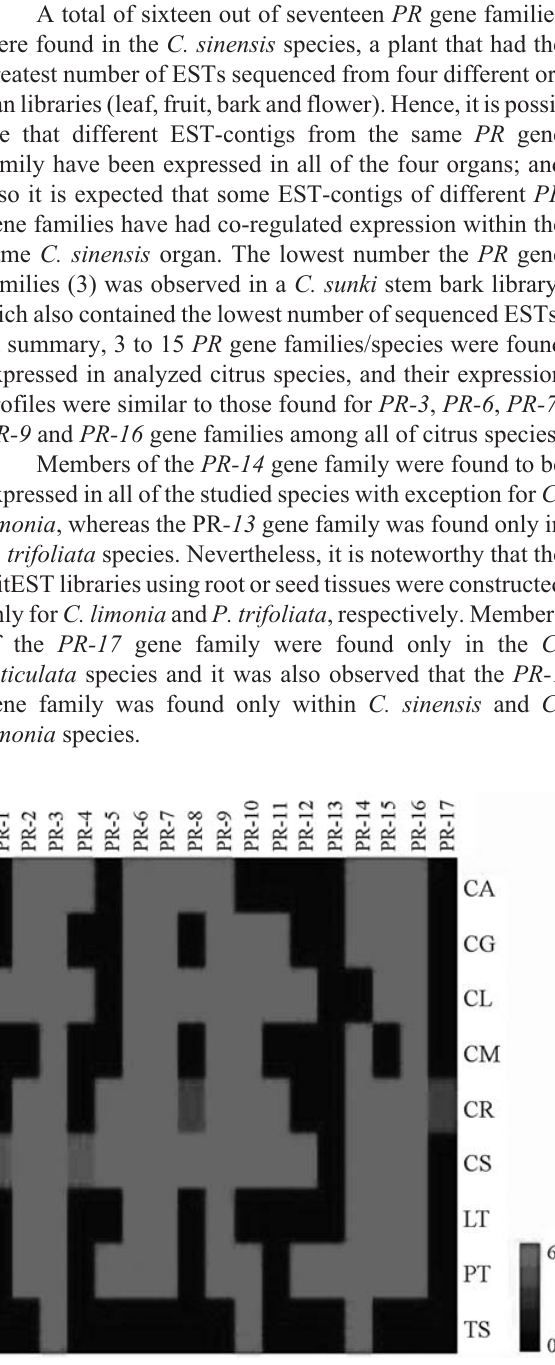
Figure 5 - PR -like gene families expression patterns present in each citrus species. Each citrus species is represented by a single row; each PR gene family ( PR-1 to PR-17 ) is represented by a single column. Data represent the relative number of PR reads from a specific library in each EST-contig per 1,000 reads. CA, Citrus aurantium ; CG, C. aurantifolia ; CL, C. limonia ; CM, C. limettiodes ; CR, C. reticulata ; CS, C. sinensis ; LT, C. latifolia ; PT, Poncirus trifoliata ; TS, C.